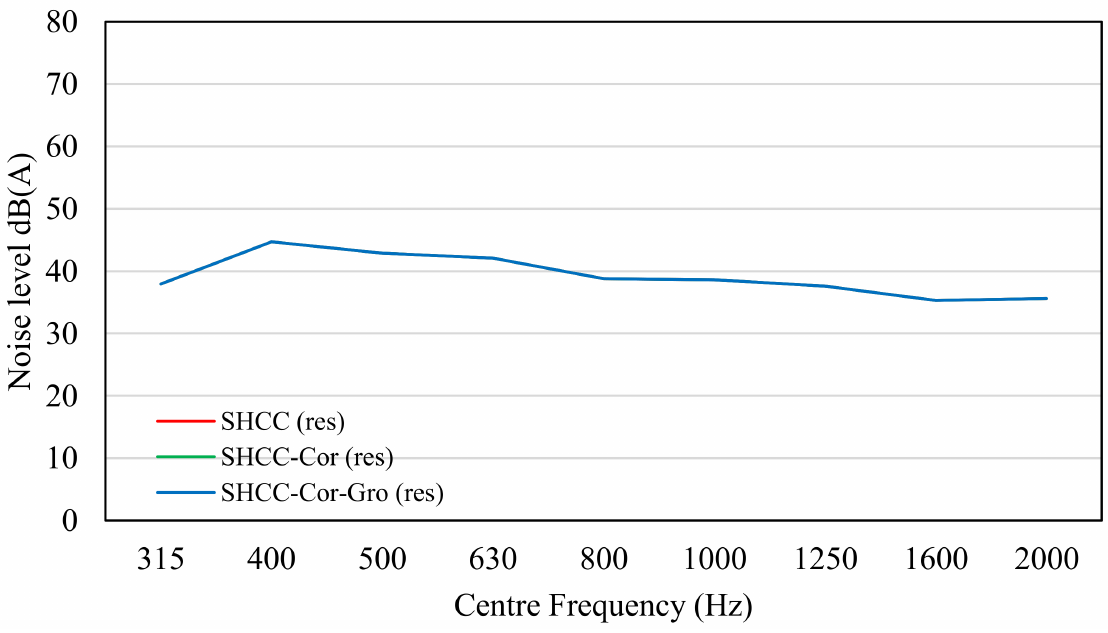
Figure 7. Noise level of SHCC, SHCC-Cor, and SHCC-Cor-Gro based on residual